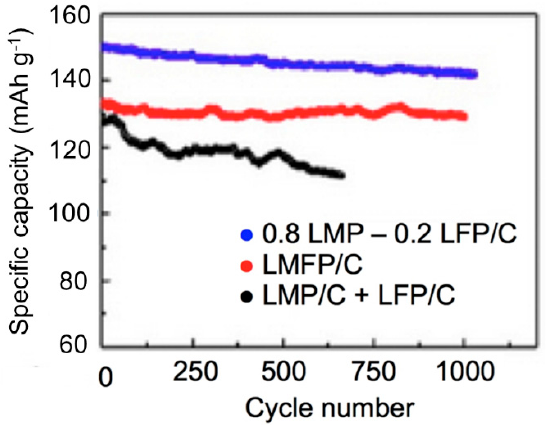
Figure 7. Cycling performances at a discharge rate of 1 C for the core-shell structure 0.8LMP-0.2LFP/C, the solid solution with the same Mn/Fe molar ratio LiMn 0.8 Fe 0.2 PO 4 (LMFP/C), and the simple mixture LMP/C + LFP/C. Reproduced from [205].